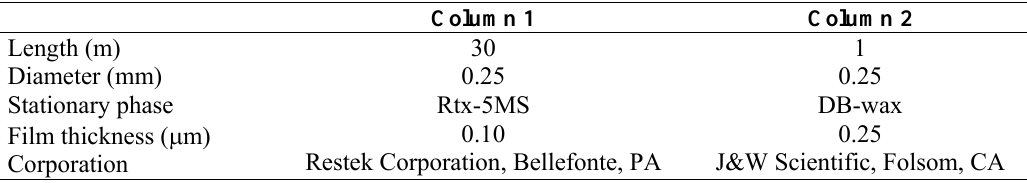
Table 5. Features of the GC×GC column